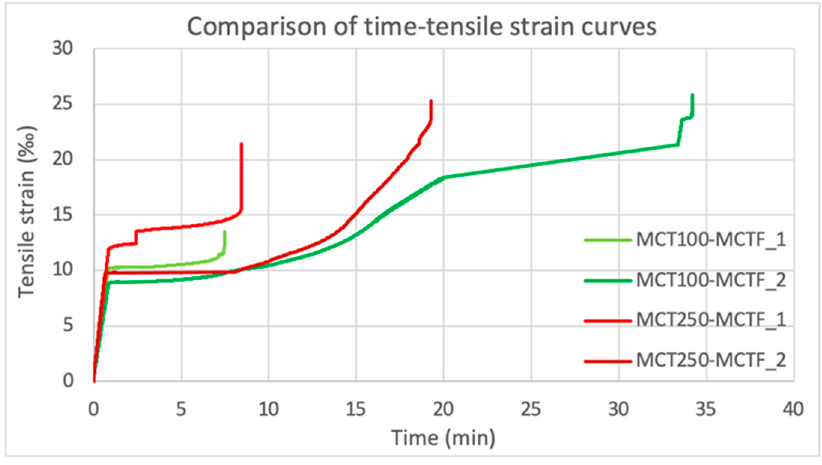
Figure 20. Time–strain curves of the specimens MCT50-MF_1, MCT100-MCTF_1-2 and MCT250- MCTF_1-2.